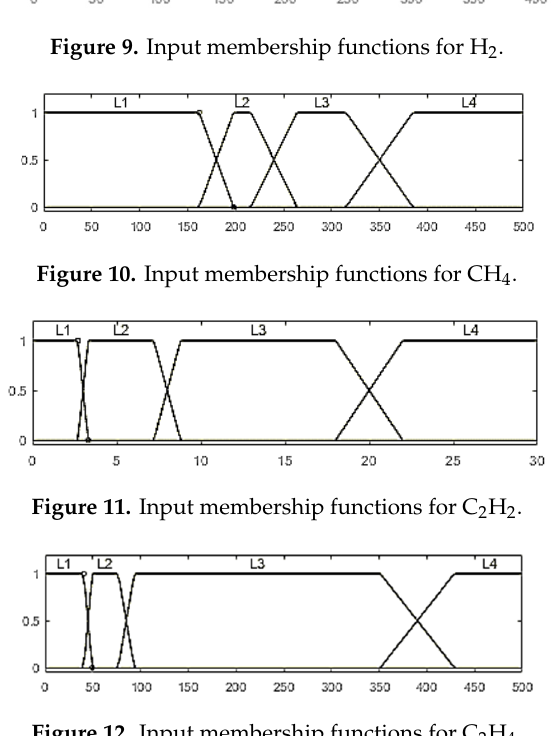
Figure 13. Input membership functions for C 2 H 6 . Figure 14. Faults’ severity output membership functions. 1. If (DPM is C1) and (GasLVRT is C1) then (FaultsSeverity is A) 2. If (DPM is C2) and (GasLVRT is C2) then (FaultsSeverity is B) 3. If (DPM is C2) and (GasLVRT is C3) then (FaultsSeverity is B) 4. If (DPM is C2) and (GasLVRT is C4) then (FaultsSeverity is C) 5. If (DPM is C3) and (GasLVRT is C2) then (FaultsSeverity is C) 6. If (DPM is C3) and (GasLVRT is C3) then (FaultsSeverity is C) 7. If (DPM is C3) and (GasLVRT is C4) then (FaultsSeverity is D) 8. If (DPM is C4) and (GasLVRT is C2) then (FaultsSeverity is D) 9. If (DPM is C4) and (GasLVRT is C3) then (FaultsSeverity is D) 10. If (DPM is C4) and (GasLVRT is C4) then (FaultsSeverity is E) Figure 15. Rules for Faults’ Severity Fuzzy Logic. This fuzzy logic implementation is then to be applied to the in-service power transformers DGA data. The results will be presented in the next section. 4.2. Faults’ Severity Results The fuzzy logic implementation of faults’ severity based on DPM interpretation, gas rate, and gas level has been developed. This section describes the evaluation of the model proposed. Initially, as many as 448 sets of recent DGA of in-service power transformer data were collected. These power transformers are from the same populations as the ones that were used to form typical values and rates. The faults’ severity model will be applied to these transformers to get the severity of this power transformer population due to faults. The results were compared to two other approaches. Further implementation of this fuzzy logic was done to four transformers with historical data, with four years of data to highlight the applicability of the model to assess historical data of power transformer faults’ severity. Figure 16 shows the results of faults’ severity of 448 power transformers observed. As many as 324 transformers were in the normal condition (category A), whereas 30 power transformers were in category B, 57 transformers needed caution (category C), 30 transformers were in poor condition (category D), and seven others were in very poor faults’ severity (category E). The next section discusses these results and compares them to other previously proposed approaches such as HI DGA in References [9–11] and TDCG in Reference [26].